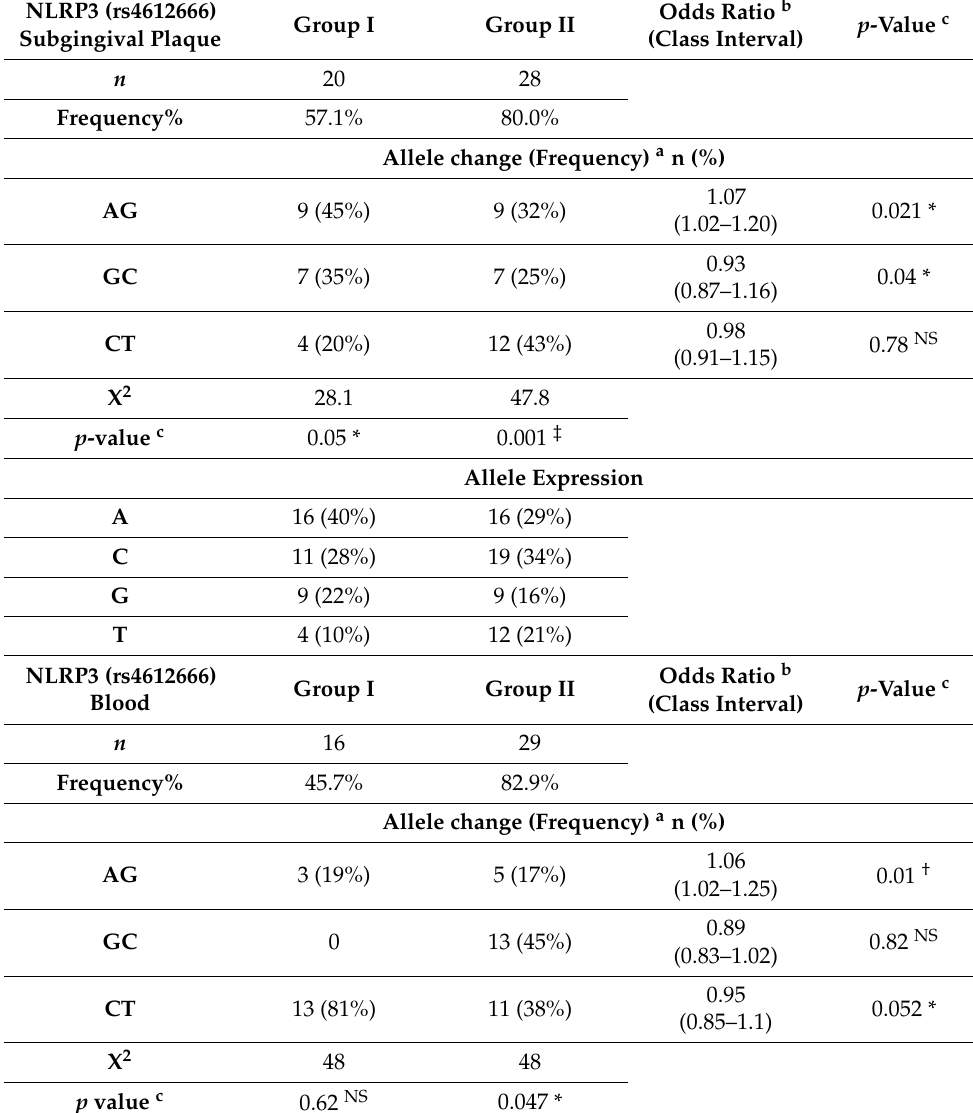
Table 3. Allele change (Frequency) of NLRP3 (rs4612666) gene polymorphisms among Group I and Group II in subgingival plaque and blood